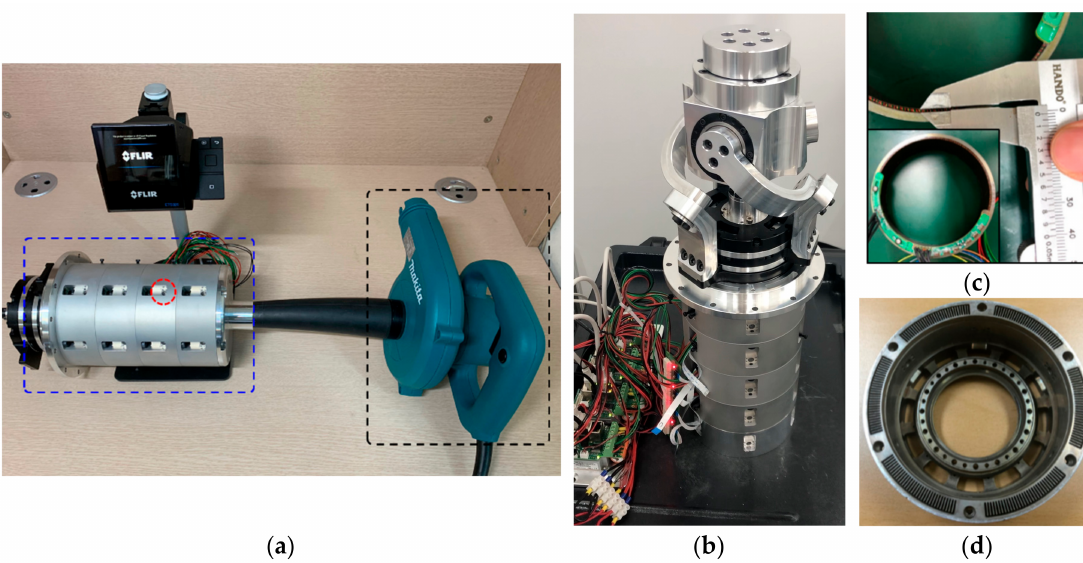
Figure 7. Prototype of the proposed design module; ( a ) Experimental setup of the thermoelectric camera and prototype module (the red circle shows the hole for measuring stator surface temperature, the blue square shows the prototyped CoSMo actuator set, and the black square shows the blower for the forced circulation of air); ( b ) Prototype module including joint part; ( c ) Stator of the frameless slotless motor; ( d ) Housing part with built-in